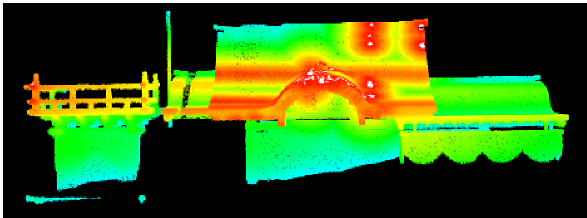
Figure 8. Opaque visualization of the simulated collision between the Ofune-hoko float and the electric wires on Sanjo street. The white colour shows the collision areas, and the rainbow colours show the high collision risk areas.